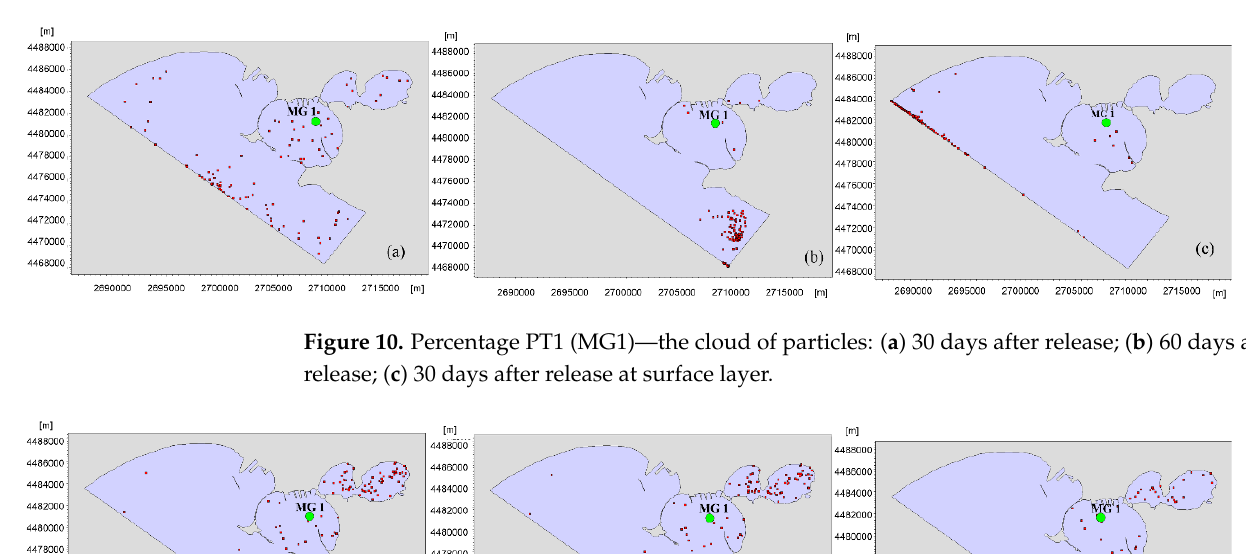
Figure 10. Percentage PT1 (MG1) — the cloud of particles: ( a ) 30 days after release; ( b ) 60 days after release; ( c ) 30 days after release at surface layer.